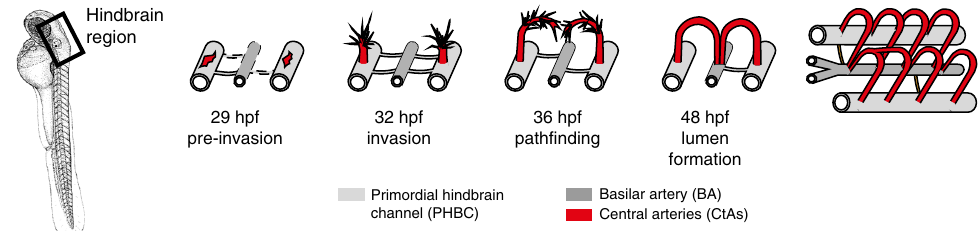
Primordial hindbrain channel (PHBC) Central arteries